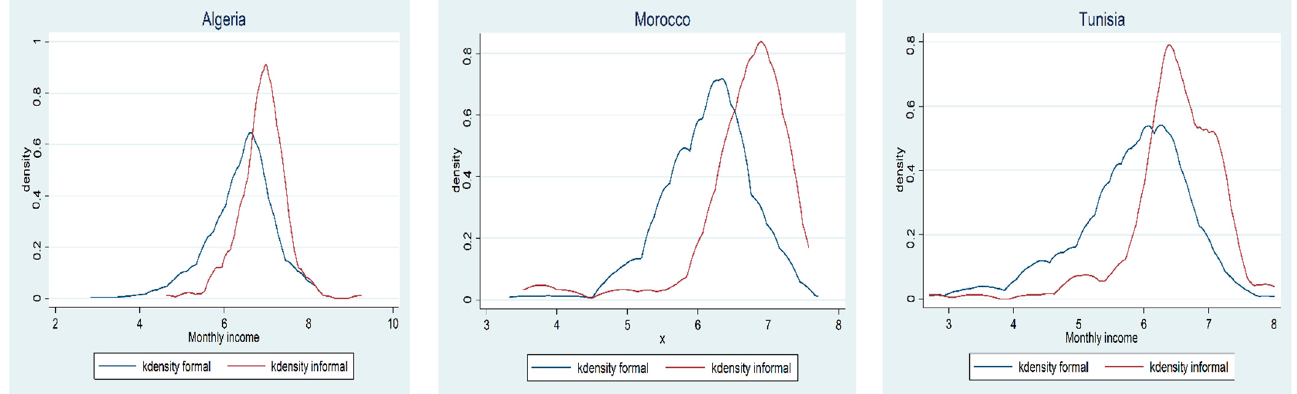
24 of 27 Table A12. Variables description. Variables of the Models Definition/Description Urban